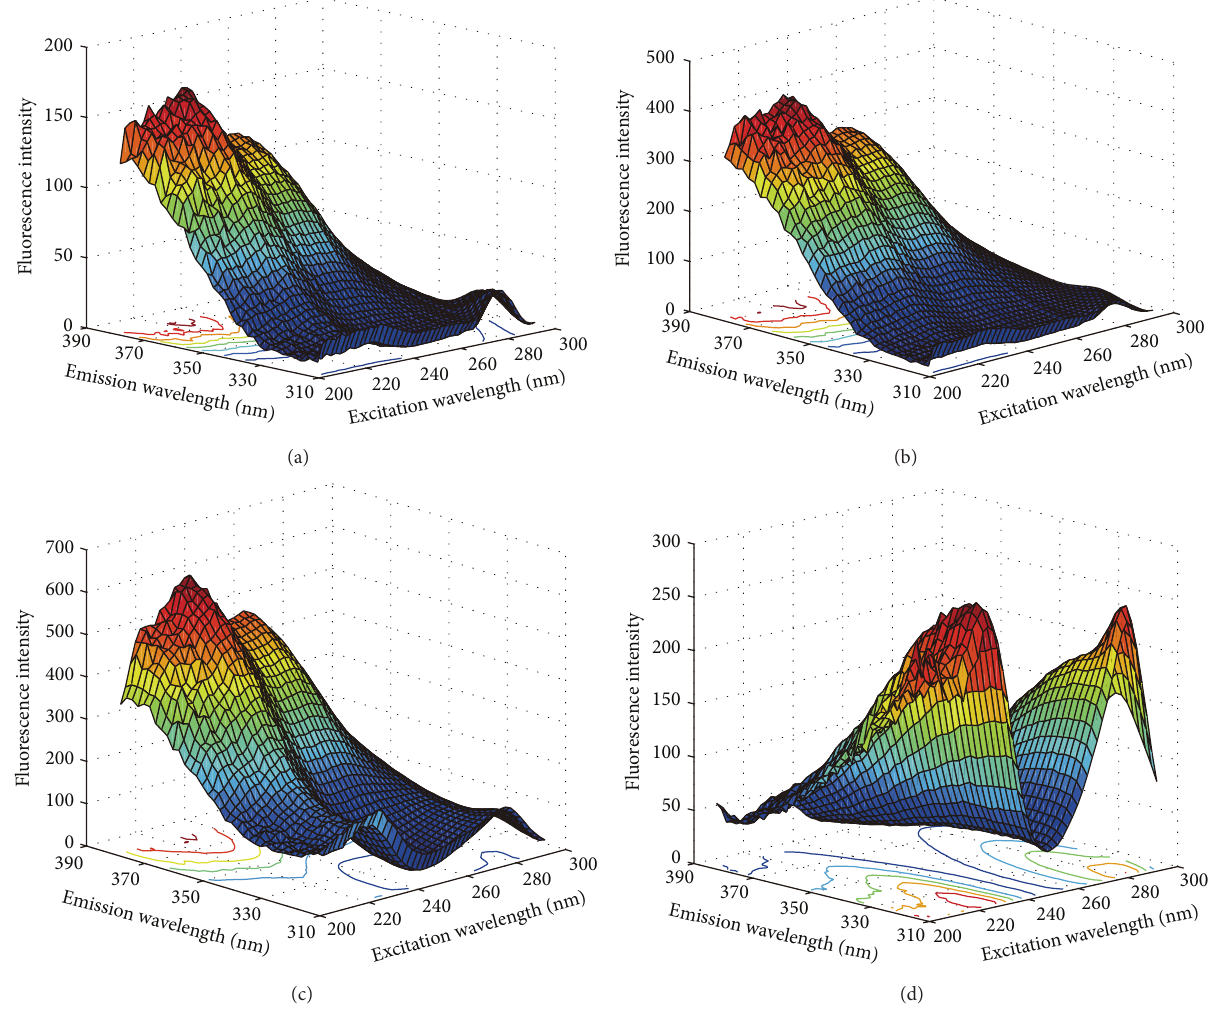
Figure 1: Three-dimensional plots of the excitation-emission matrix fluorescence spectra: (a) 318.6 ng/mL pure valsartan; (b) 318.6 ng/mL valsartan and 50 𝜇 L SDS; (c) 318.6 ng/mL valsartan and 50 𝜇 L SDS in human plasma; (d) blank human